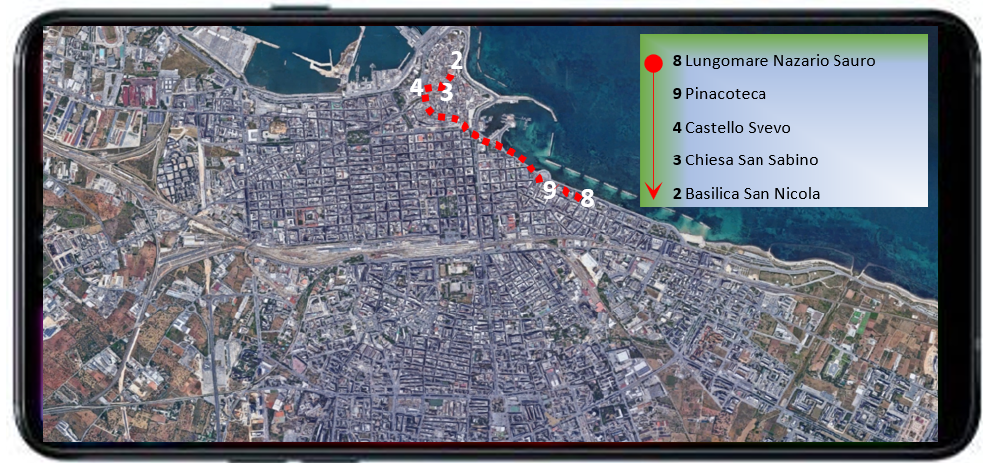
Figure 21. The GUI of the return